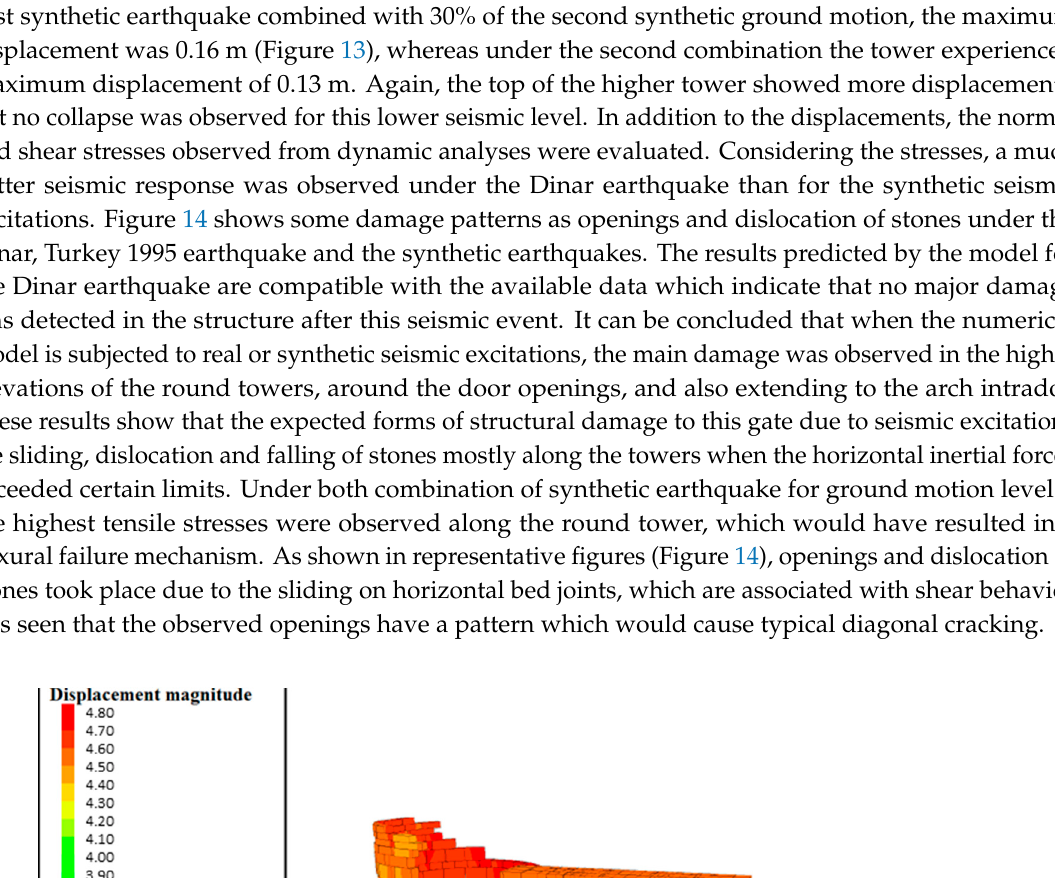
Figure 11. Displacement magnitude under Dinar, Turkey 1995 earthquake .